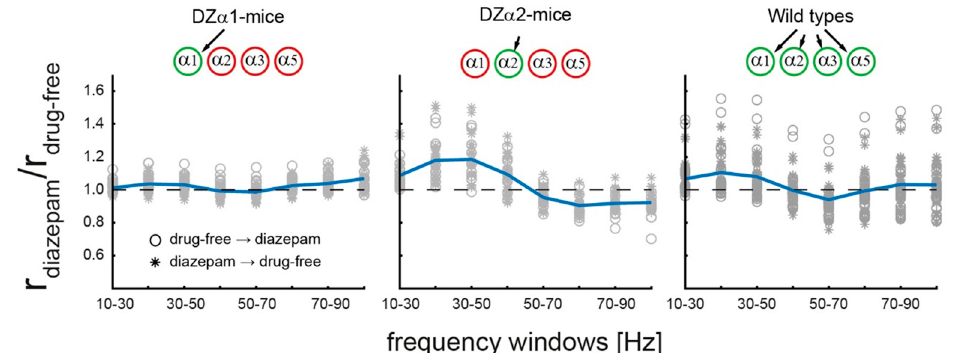
Figure 5. Correlation of LFP signals recorded on all electrodes of the 2 × 2 array. The relative correlation is plotted for different frequency bands, using windows of 20 Hz in size. LFP signals were band-pass filtered. Cutoff frequencies were 10 and 100 Hz, respectively. Blue lines: Mean ratio across sessions and animals in one genotype. Symbols denote the sequence of the drug-free and diazepam session (Open circles: drug-free session first, Asteriks: Diazepam session first). In DZ α 2-animals, enhancement of correlation in the low γ -frequency range is most pronounced, but absent in DZ α 1- mice.